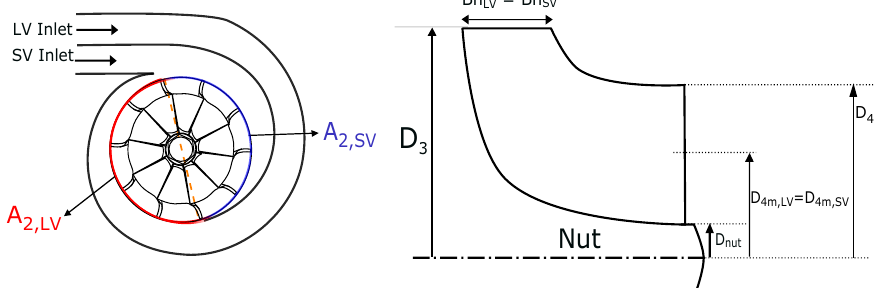
Figure 10. Geometrical description of dual-volute turbine